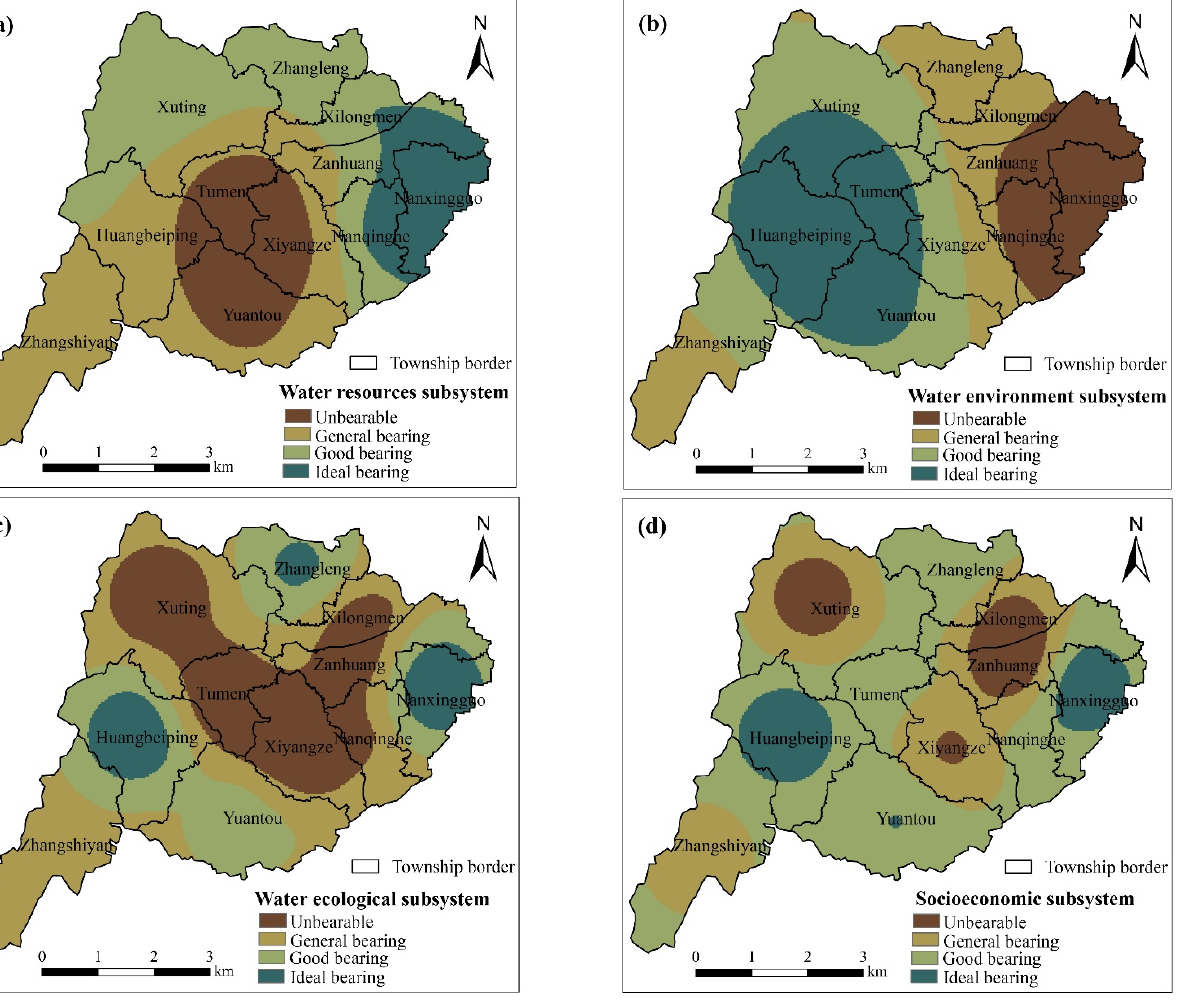
Figure 4. Maps with the spatial distribution of four subsystems’ classification: ( a ) Water resources subsystem quality classification from scoring values; ( b ) Water environment subsystem quality classification from scoring values; ( c ) Water ecological subsystem quality classification from scoring values; ( d ) Socioeconomic subsystem quality classification from scoring values.